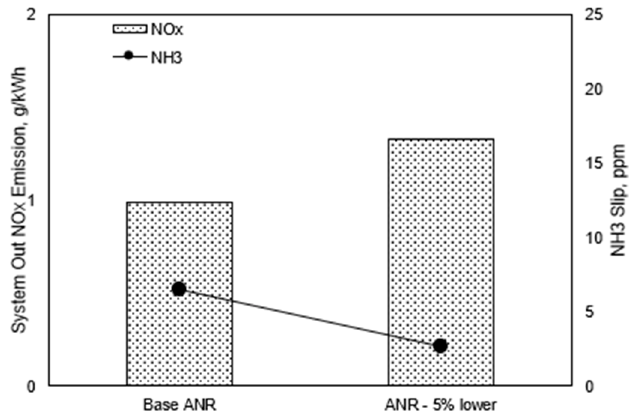
Figure 15. NOx emission results and NH 3 slip results during NRTC considering ANR adjustment.